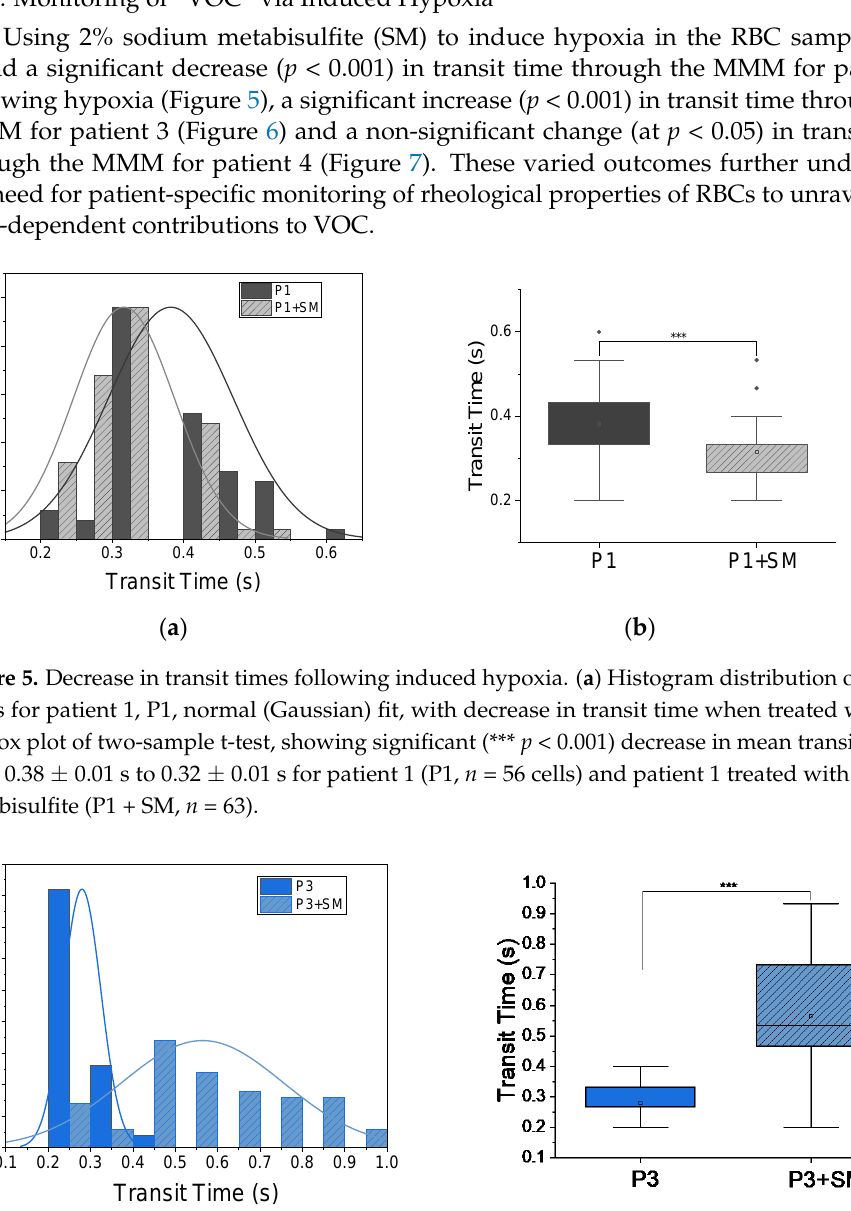
Figure 6. Increase in transit times following induced hypoxia. ( a ) Histogram distribution of transit times for patient 3 (P3, n = 56), normal (Gaussian) fit, with increase in transit time when treated with SM (P3 + SM, n = 67). ( b ) Box plot of two-sample t -test, showing significant (*** p < 0.001) increase in mean transit time tt from 0.28 ± 0.01 s for P3 to 0.56 ± 0.02 s for P3 +